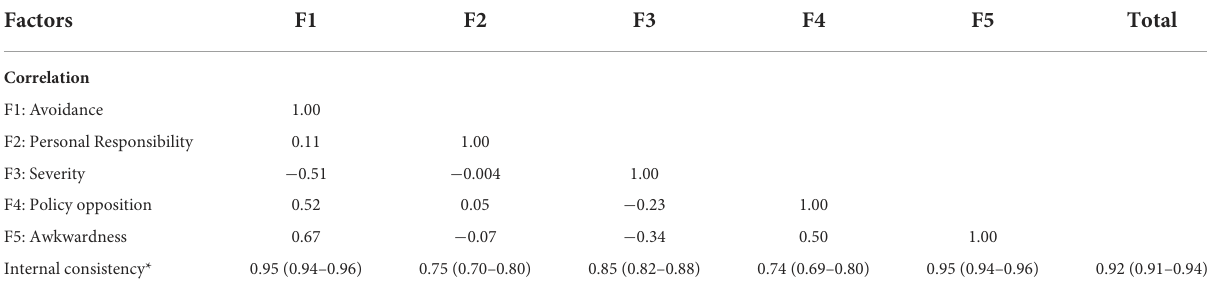
TABLE 3 Correlation coefficient matrix and internal consistency of each